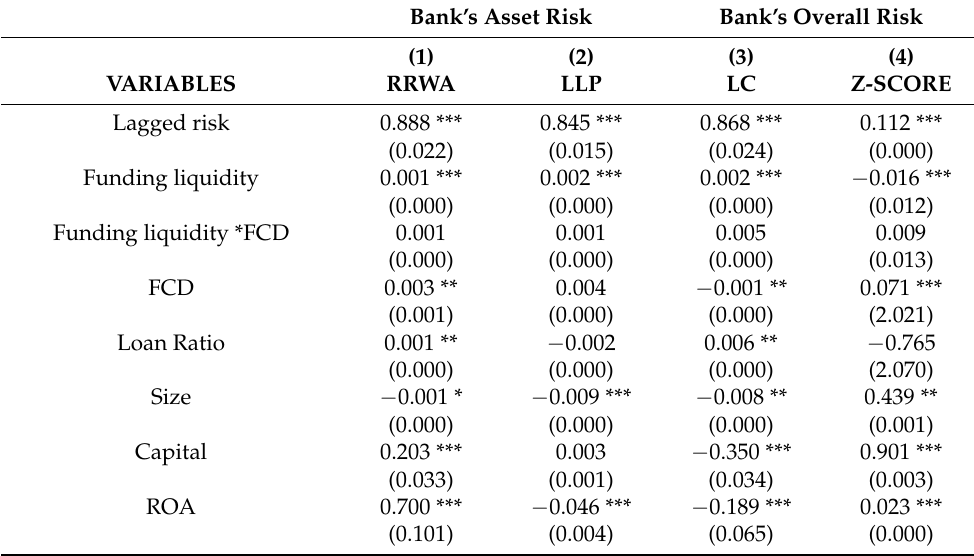
Table 5. Relationship between funding liquidity ratio and banks risk during